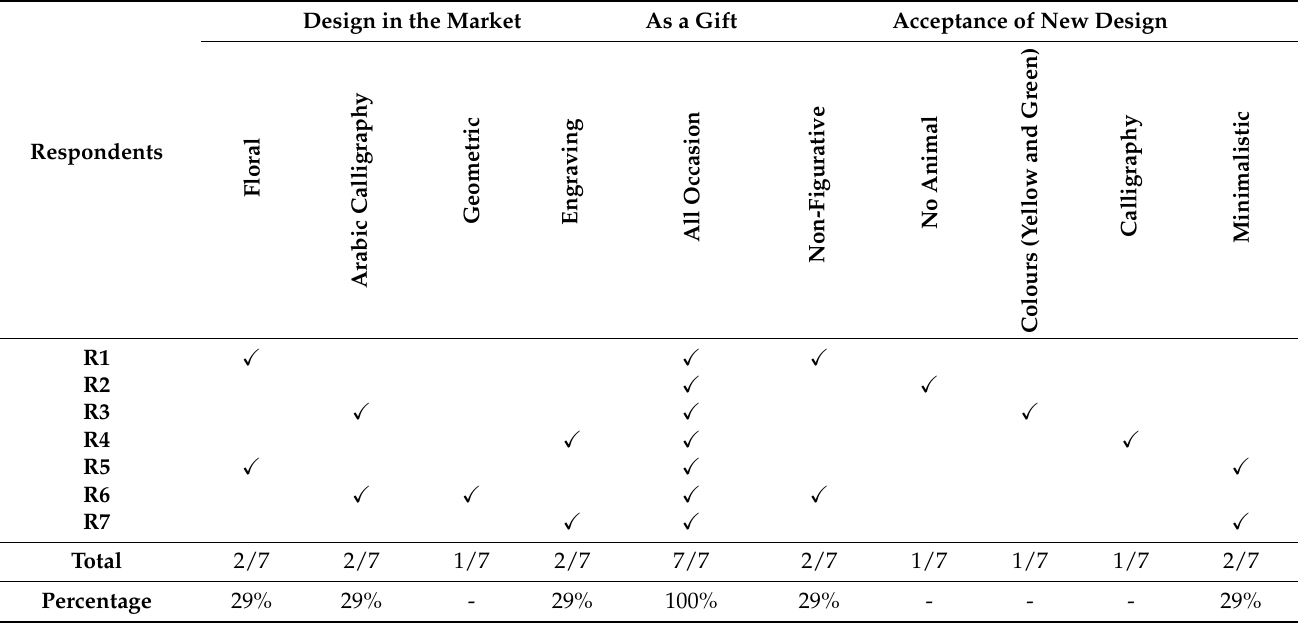
Table 4. Analysis of interview content of Question